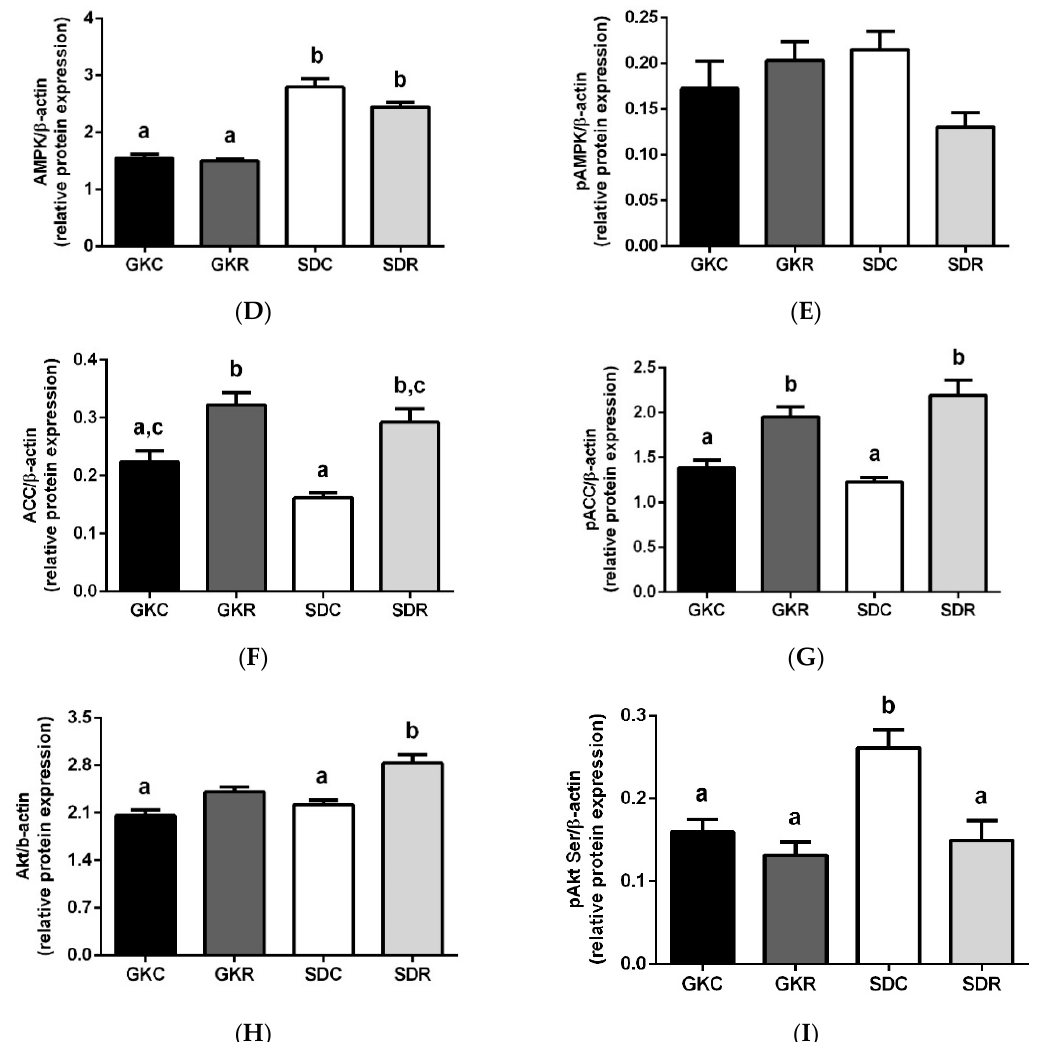
Figure 4. Effects of resveratrol on liver lipids, and also expression and phosphorylation of AMPK, ACC and Akt in liver tissue of GK and SD rats. Triglycerides ( A ), non-esterified fatty acids ( B ). Western blot immunodetection with antibodies to the indicated proteins, β -actin expression used as loading control ( C ). Protein levels relative to β -actin quantified by densitometry: Total AMPK ( D ) and pAMPK ( E ), total ACC ( F ) and pACC ( G ), total Akt ( H ) and pAkt ( I ). Results are representative of at least two independent experiments. GKC—Goto-Kakizaki control rats, GKR—Goto-Kakizaki resveratrol-treated rats, SDC—Sprague–Dawley control rats, SDR—Sprague–Dawley resveratrol-treated rats. Results are expressed as the means ± SEM from 10 rats in each group. Values with di ff erent letters are significantly different at p < 0.05.